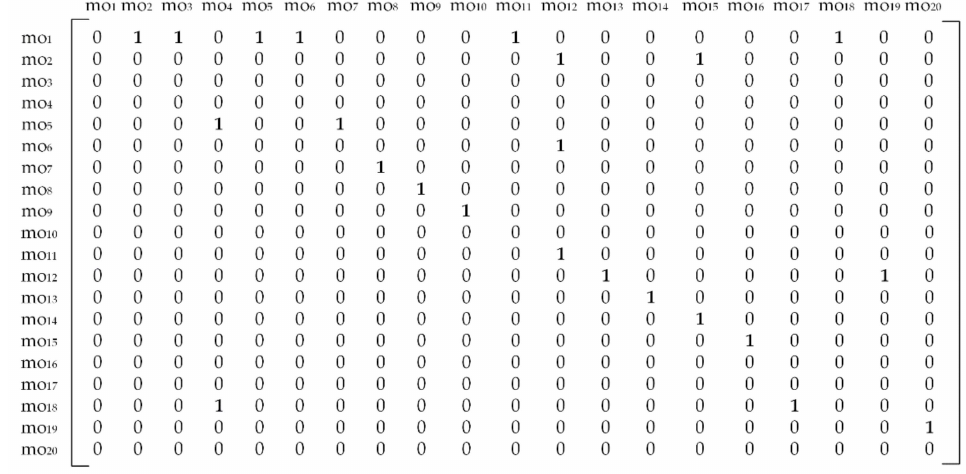
Figure 4. Schematic representation of precedence